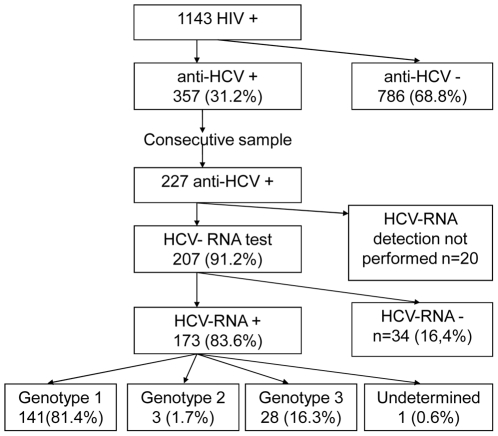
HCV-HIV prevalence and genotype distribution.Flowchart of inclusion in the different stages of the study, and patient's prevalence of anti-HCV positive, HCV-RNA positive and HCV genotypes.